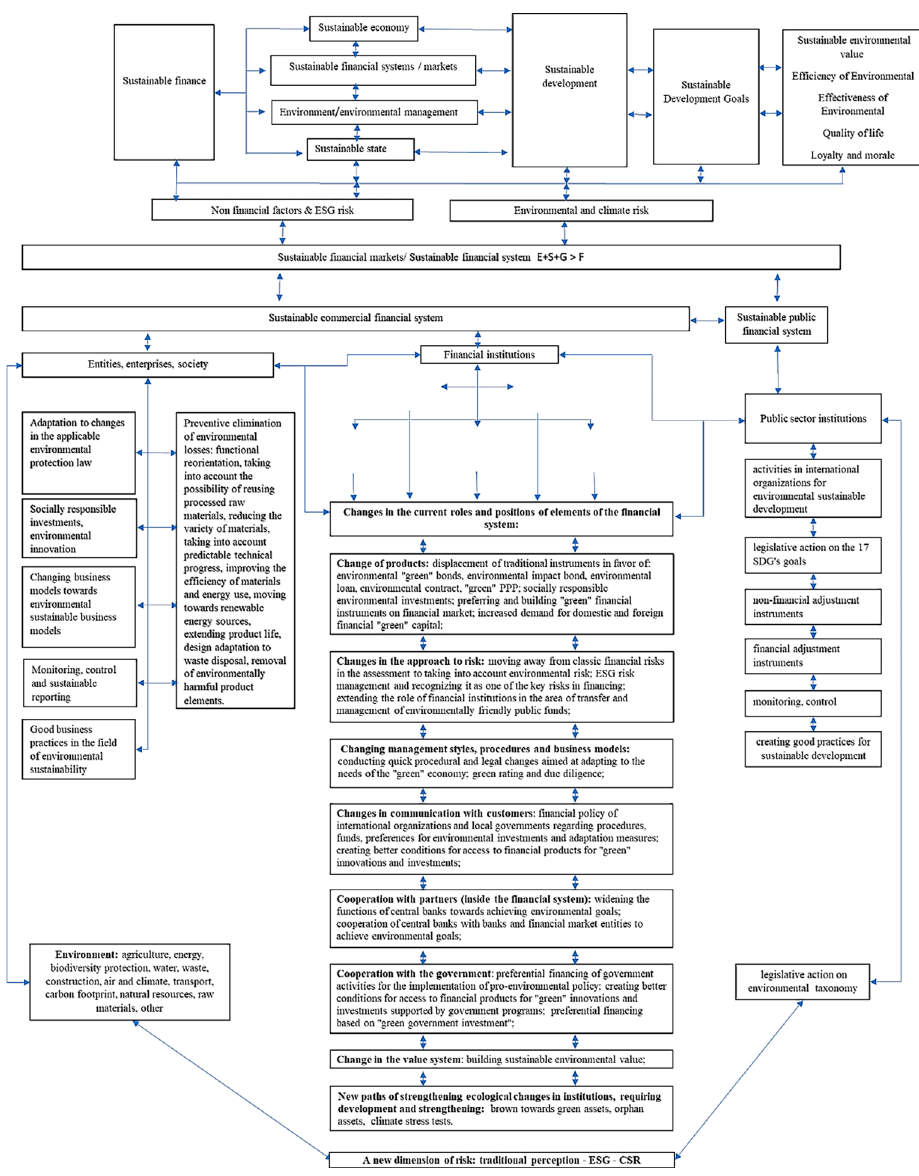
Figure 6. Sustainable finance model for sustainable economy – environmental